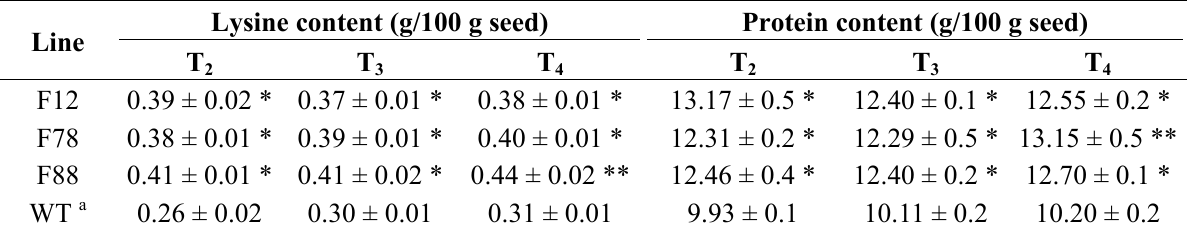
, T and T kernels in three transgenic lines. 2 3 4